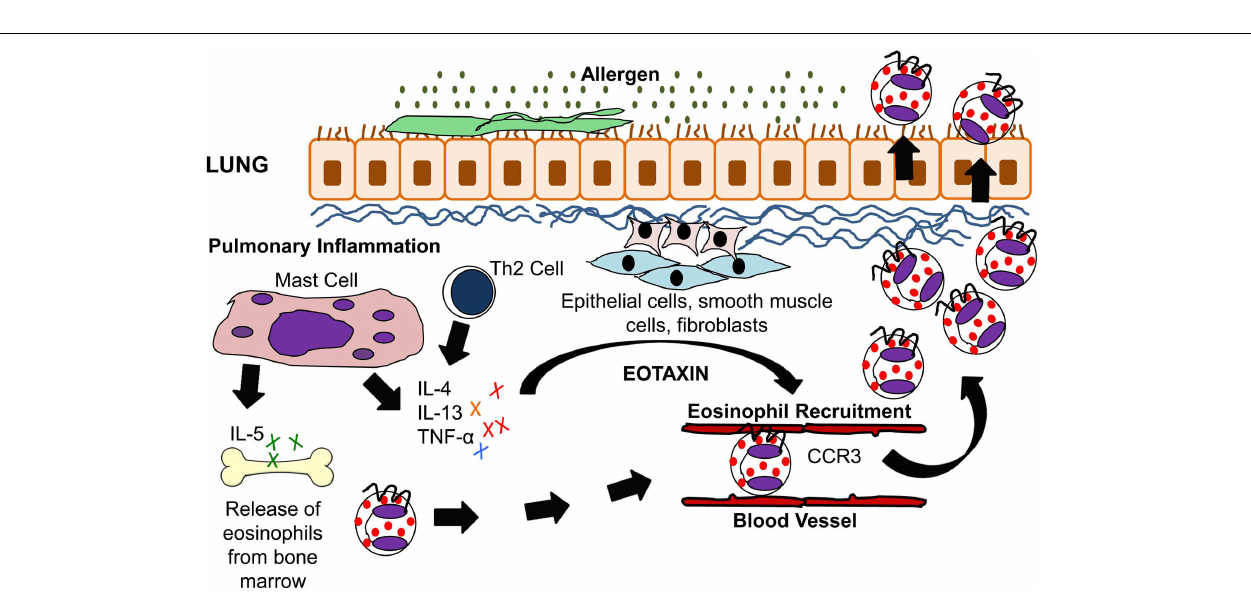
eotaxin. IL-5 modulates eosinophil migration from the bone marrow through its action on eotaxin andTh2 cells. Eotaxin on the other hand modulates eosinophil homing to the lung tissue via CCR3 which is present on